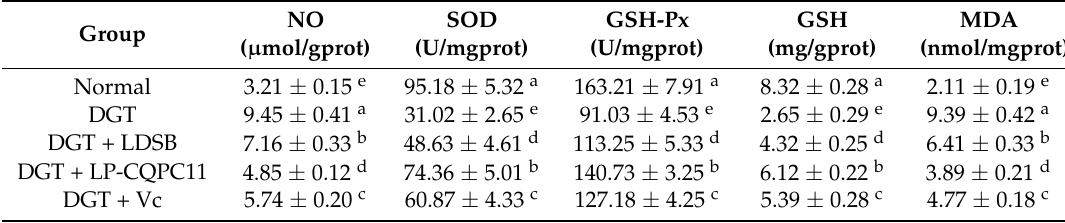
Table 3. The levels of NO, SOD, GSH-Px, GSH, and MDA in liver of mice ( n =